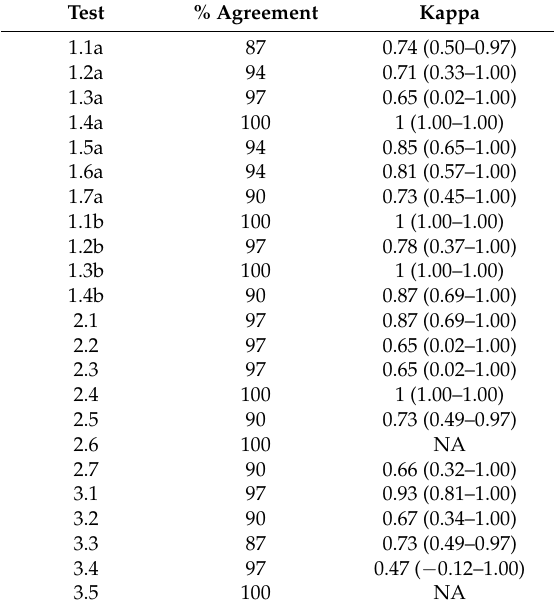
Table 2. Reliability of individual test scores; % agreements and Cohen’s kappa with 95% confidence